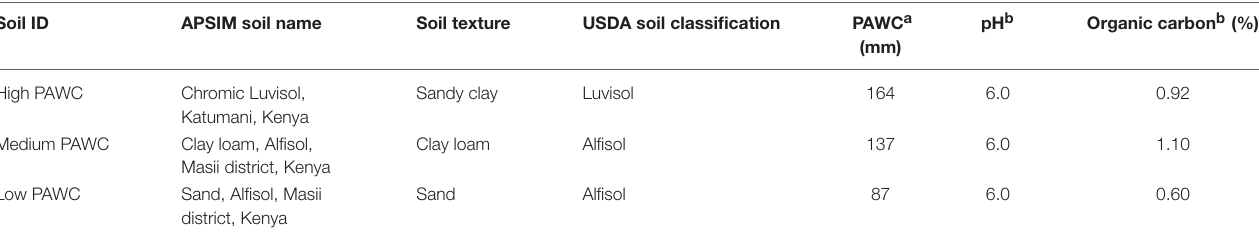
TABLE 4 | Detailed description of soils used for the simulation study and their characteristics, including soil texture, plant available water capacity (PAWC) in mm, pH, and organic carbon content in